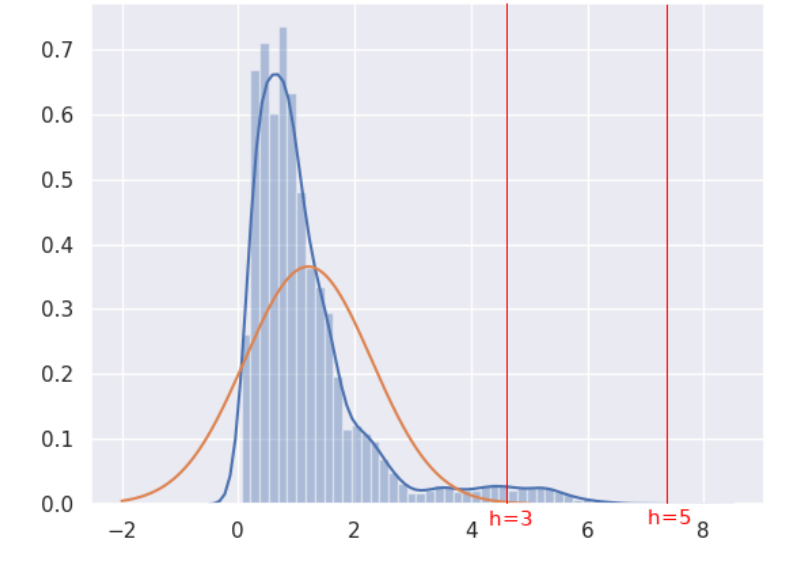
Figure 5. Distribution of errors computed on training